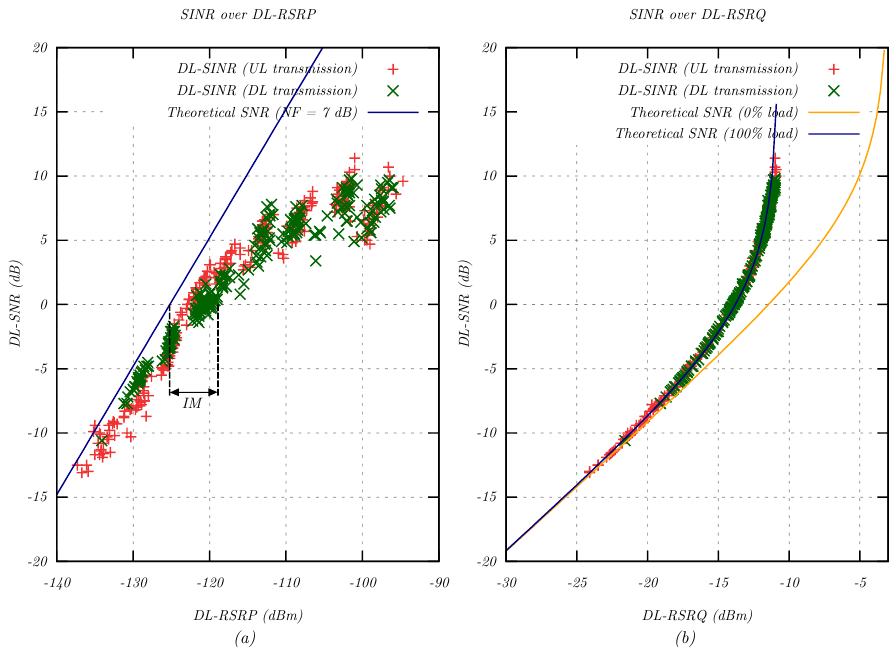
Figure 9. Analysis of the DL-SINR due to the presence of network interference for varying attenuation. ( a ) Measured DL-SINR over reported RSRP. ( b ) Measured DL-SINR over RSRQ. The solid lines show the theoretical curves for x = 2/12 (0% load) and x = 1 (100% load) according to Equation (3).